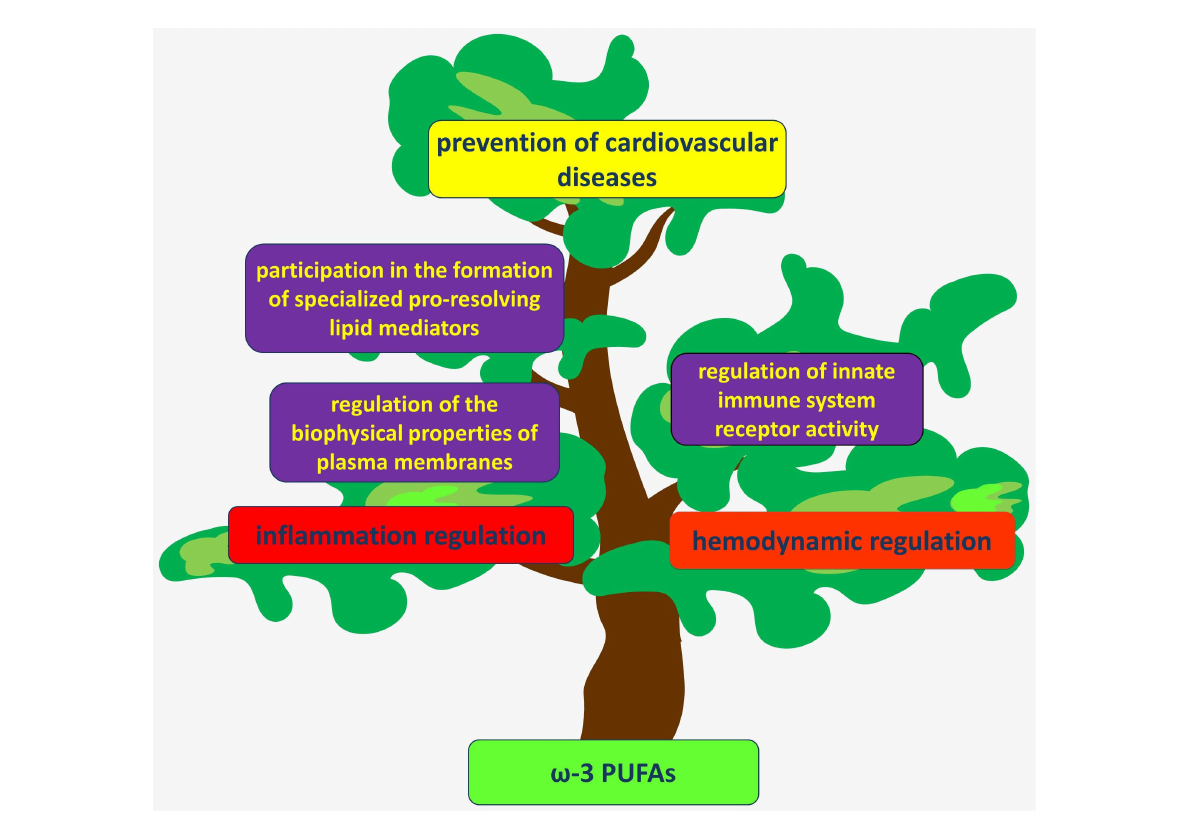
FIGURE1 PUFAs act through several mechanisms to regulate hemodynamics and inflammation in the vascular wall. Their anti-inflammatory and atheroprotective effects are considered beneficial for the prevention of various cardiovascular diseases.